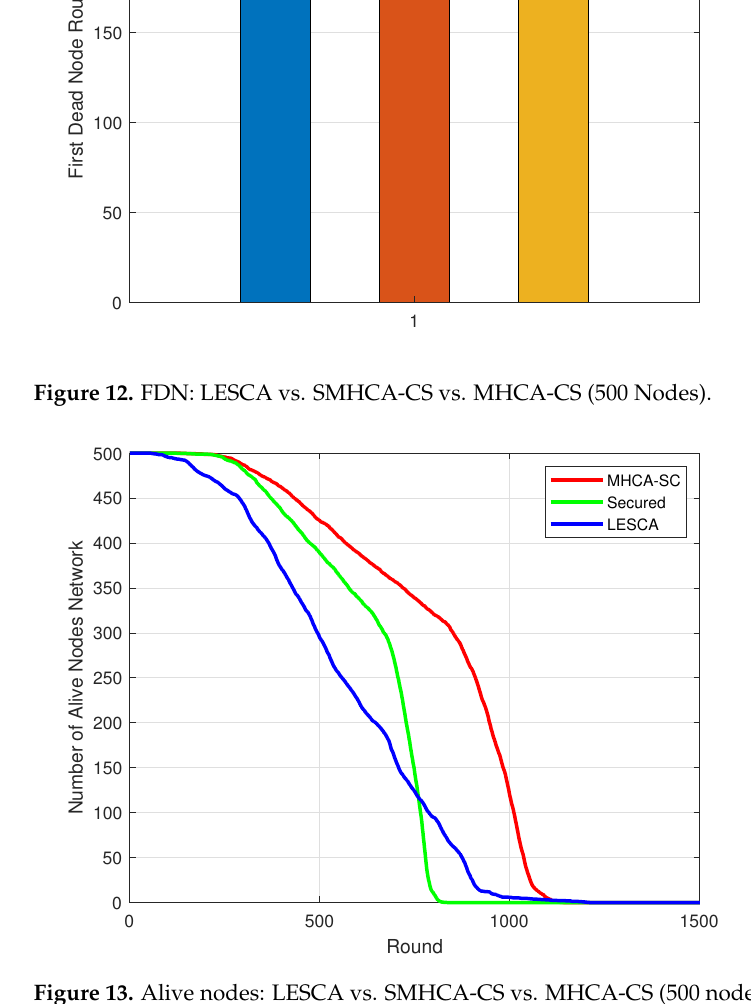
Figure 13. Alive nodes: LESCA vs. SMHCA-CS vs. MHCA-CS (500